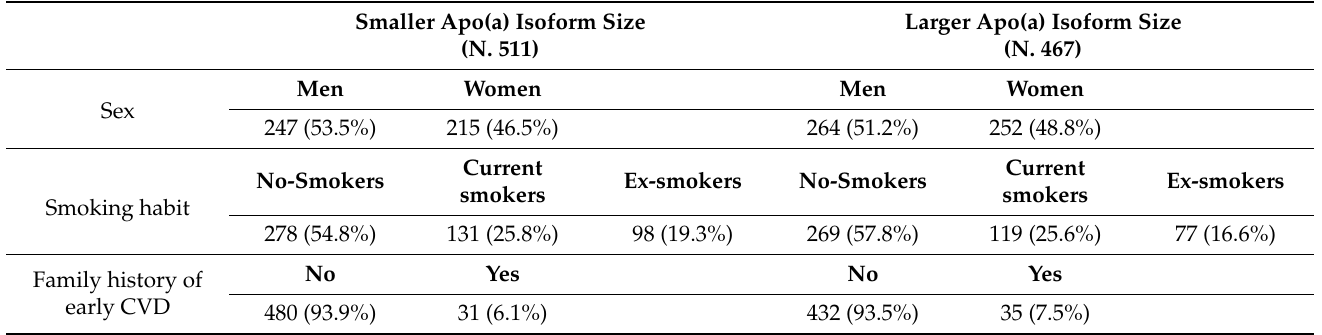
Table 1. Main characteristics of the study population in the entire cohort and by apo(a) isoform sizes.